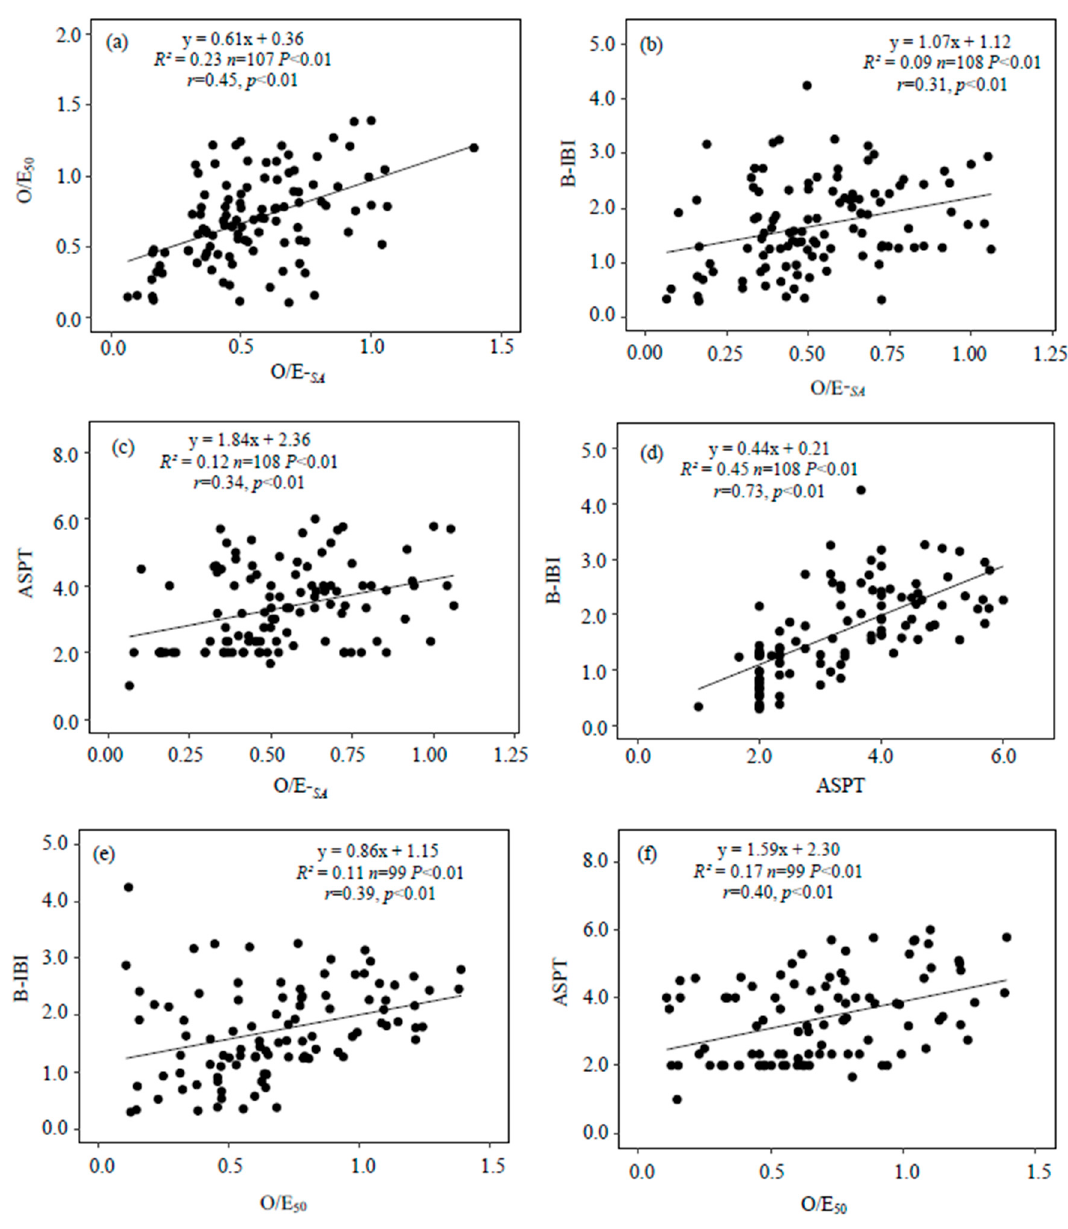
Figure 3. Relationships of O/E- SA with other indices (( a ): O/E 50 , ( b ): B-IBI, ( c ): ASPT), B-IBI with ASPT ( d ), O/E 50 with B-IBI ( e ) and ASPT ( f ) (“ r ” means coefficient of Spearman rank correlation).